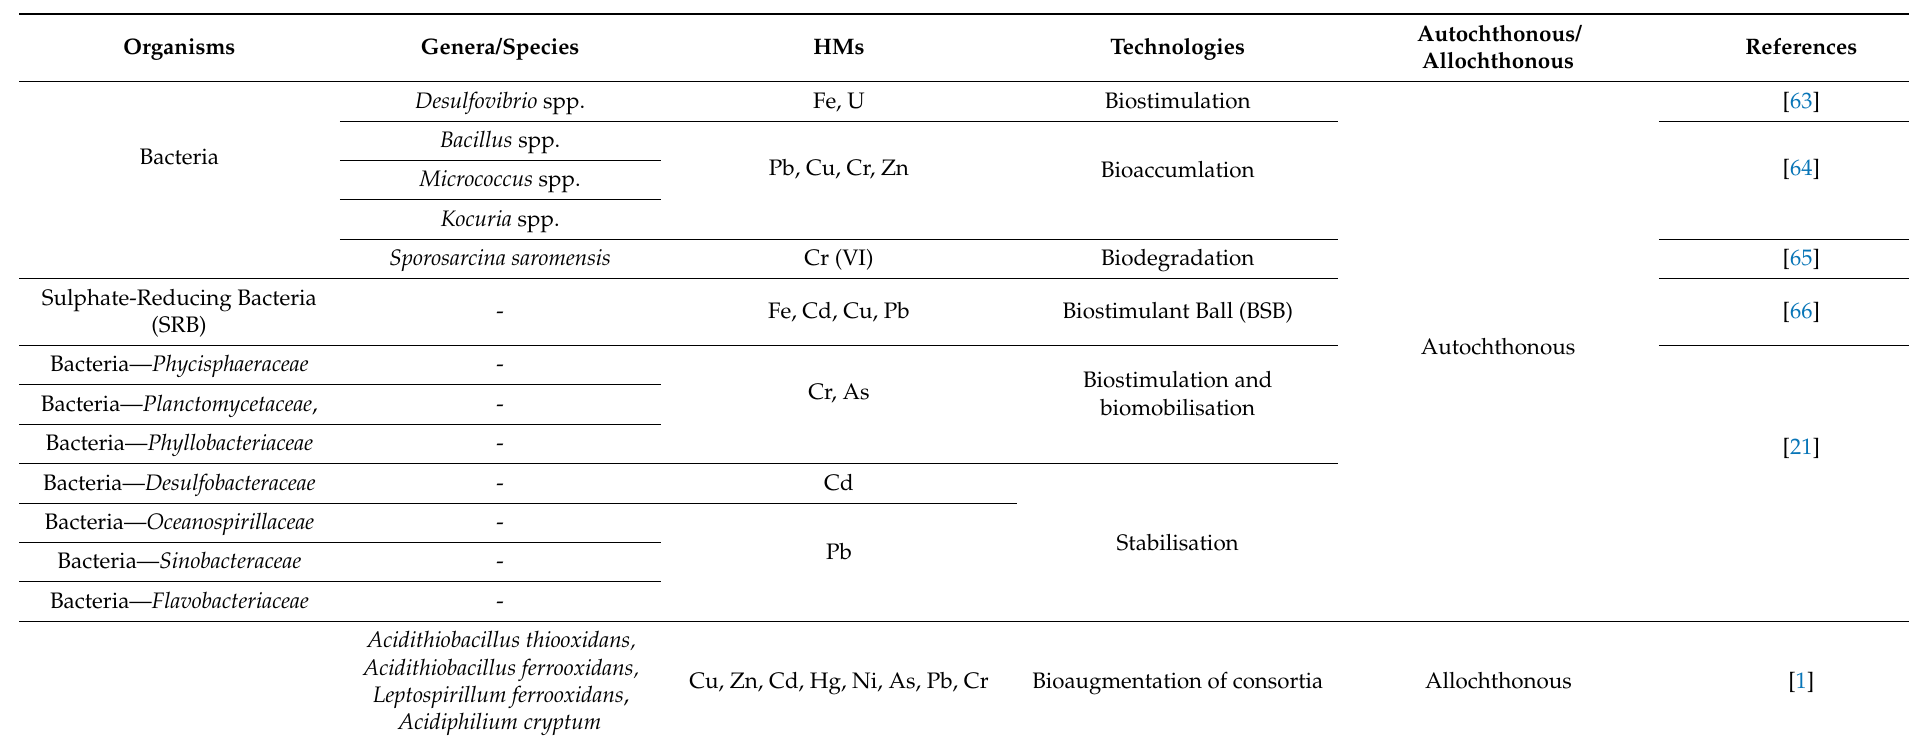
Table 1. List of the main autochthonous/allochthonous fungi, bacteria, and the related genera/species employable in marine sediment bioremediation processes of heavy metals (HMs).